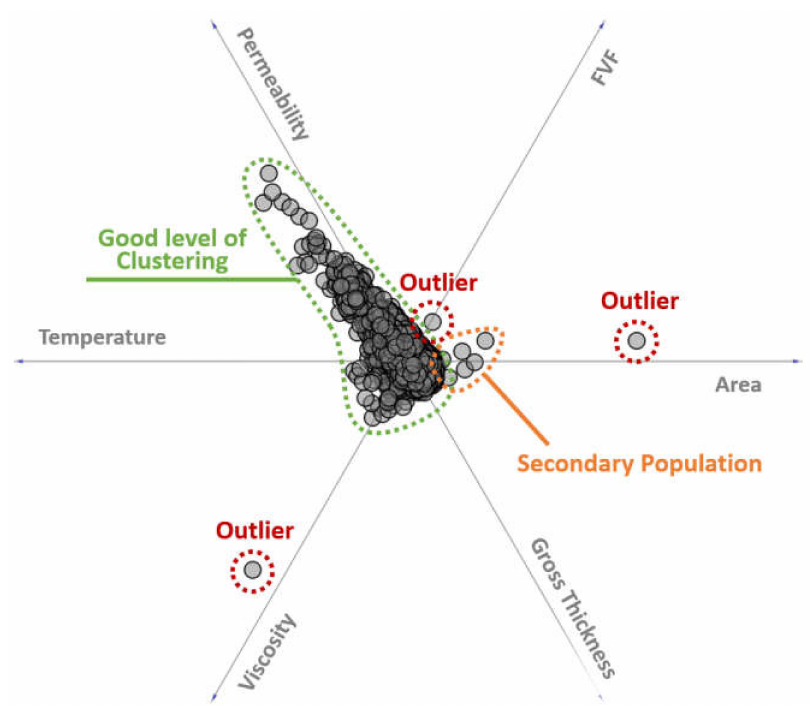
Figure 9. Normalised multivariant linear projection of attributes: area; FVF; gross thickness; perme- ability; temperature; and viscosity with outliers and possible secondary populations highlighted. Plot from Orange Data Mining software